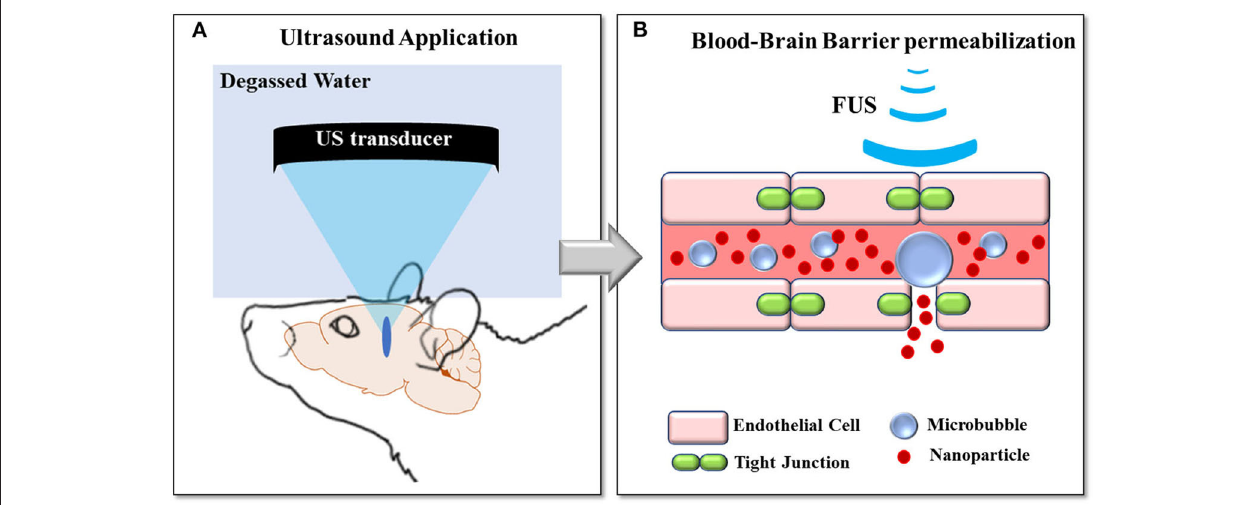
FIGURE 1 | FUS-induced BBB opening concepts: (A) Ultrasound pressure waves are converged in a millimeter-sized FS thanks to a transducer coupled to the head via a balloon filled with water. (B) Microbubbles circulating through the bloodstream cavitate within the FS region, loosening the tight junctions of endothelial cells and creating gaps between these